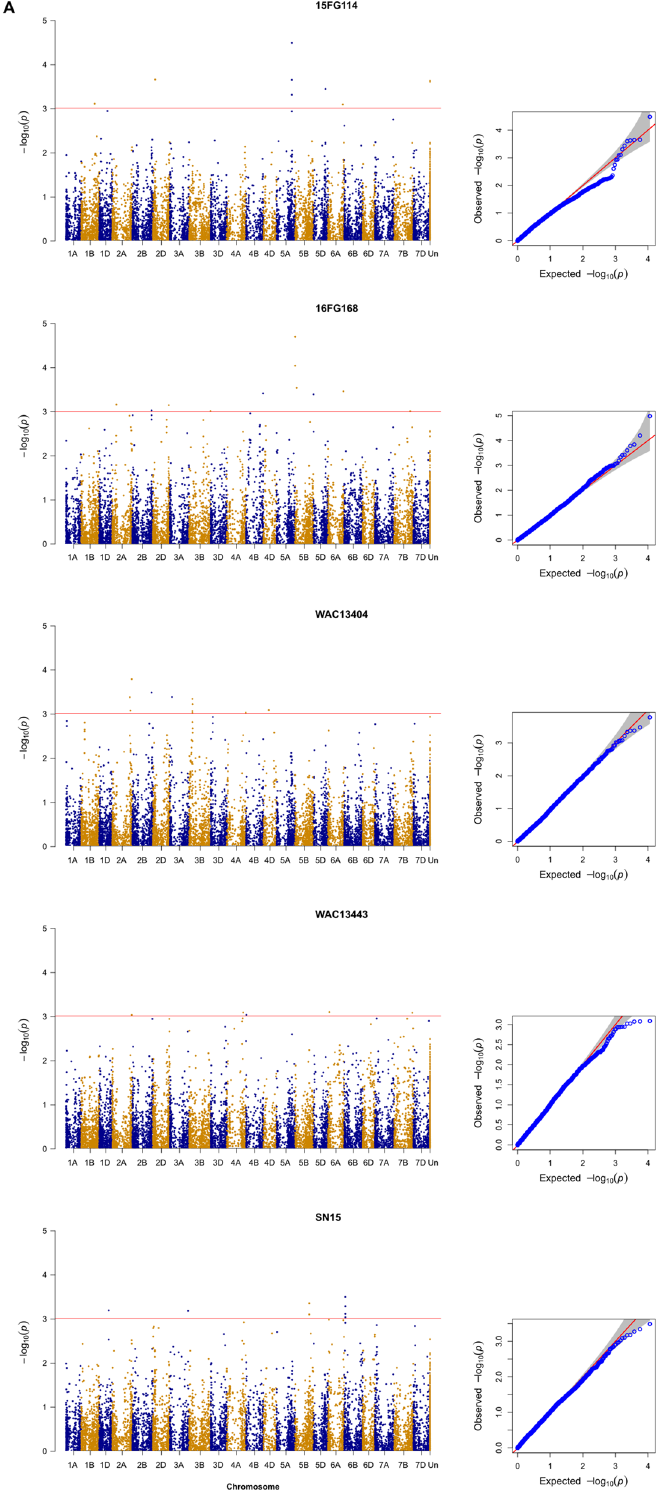
Figure 3. (Manhattan QQ): Genome-wide association scan. Manhattan plots based on Compressed Mixed Linear Model (CMLM) represent − log10( P value) for SNPs distributed across all chromosomes (x axis); Un, unknown. The red horizontal line indicates a significance threshold for SNP markers, corresponding to P < 0.001, with the exception of Tox3 infiltration (P < 1e−5). ( A ) Whole plant spray datasets from isolates as indicated. ( B ) (facing page): Culture filtrate dataset from isolates as indicated and Tox3 protein only. Quantile– Quantile (QQ) plots to right of each model show the expected null distribution of P values vs. observed P values. The Manhattan plots were produced by R ‘qqman’ package (Stephen Turner, https:// cran.r- proje ct. org/ web/ packa ges/ qqman/ qqman. pdf). The QQ plots were produced by GAPIT package in R 47